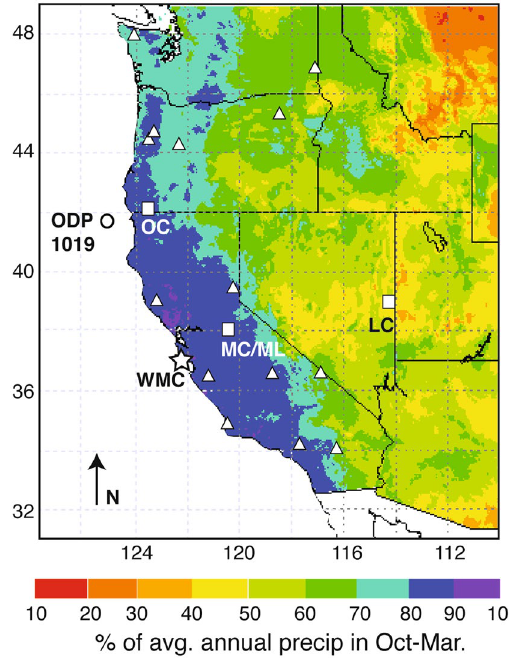
Figure 1. Location of White Moon Cave (star) and seasonality of modern precipitation in surrounding region. Boxes show locations of other Holocene speleothem records from the western United States: OC = Oregon Caves 20 , MC/ML = Moaning and McLean’s Caves 24 ; LC = Lehman Caves 28 . Circle shows location of ODP core 1019 10 . Triangles show locations where event-scale δ 18 O p has been analyzed 26 . Background map is the